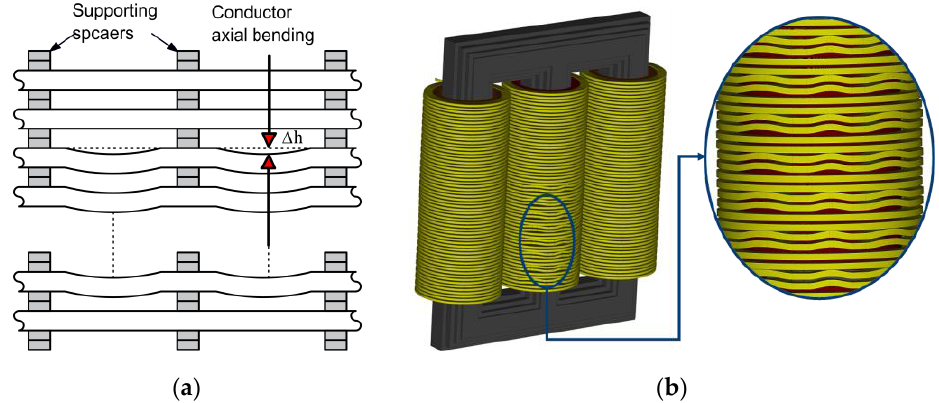
Figure 22. Representation of axial disk buckling failure mode; ( a ) schematic, ( b ) B-phase HV winding of 3D HF model.